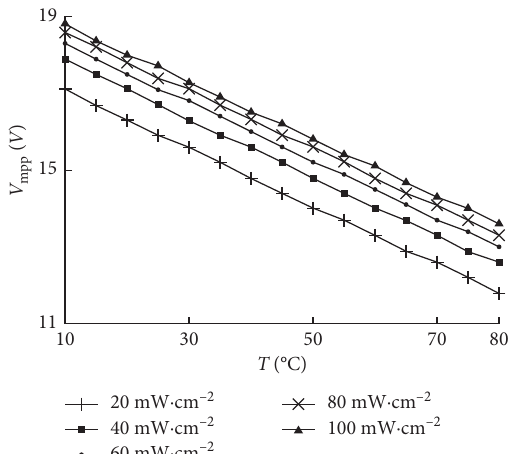
Figure 4: The relations between V